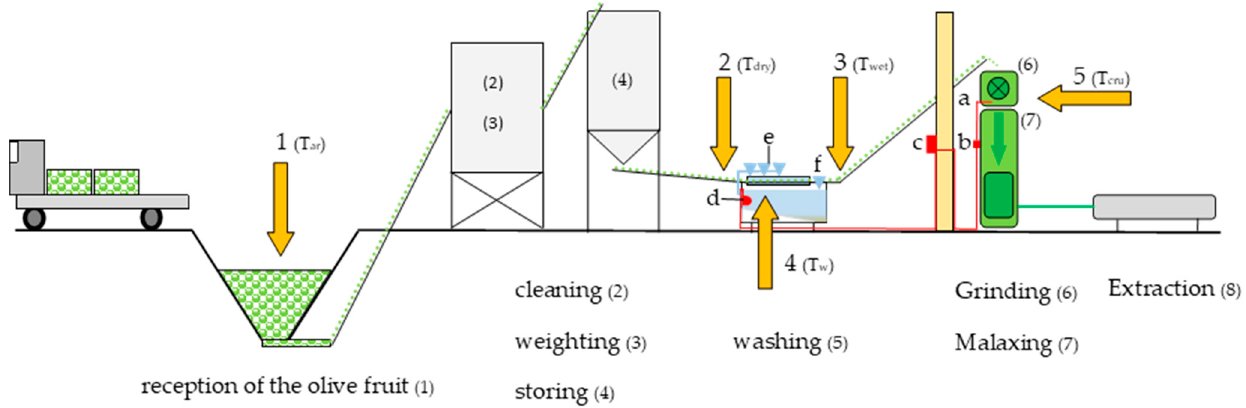
Figure 1. Processing steps of the olive fruit from their discharge up to malaxation of the paste. The different measurement points are indicated: At the reception of the olive fruit ( 1 ); before entering the washing tub ( 2 ); right after leaving the washing tub ( 3 ); and after being crushed ( 5 ). The water temperature is also continuously measured ( 4 ). The automized control system (red line) consisted of a temperature gauge at the exit of the grinder ( a ), a thermostat ( b ), a relay ( c ), and 4 heaters placed in the water tub ( d ). The water circulated in the washing tub from the lower to the upper part ( e ) and back ( f ).